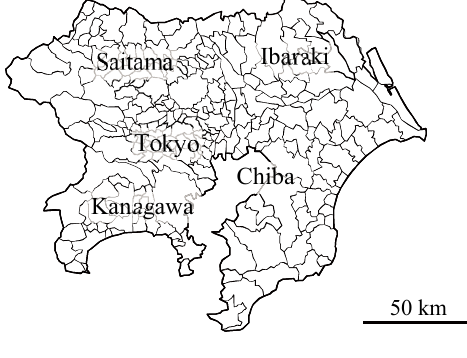
Figure 4. Survey regions.